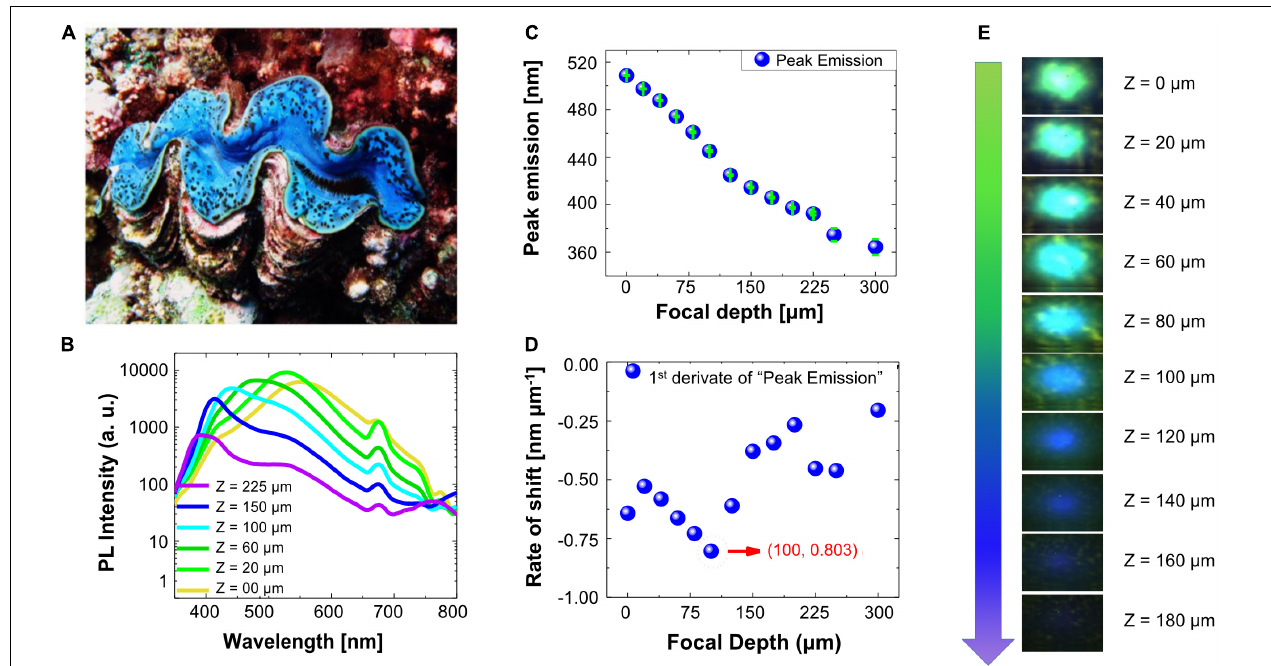
FIGURE 5 | (A) Photo of T. maxima specimen with blue mantle coloration. (B) Photoluminescence (PL) spectra of T. maxima at room temperature for different focal depths (exemplarily shown for six focal depths, ranging from mantle surface to 225 µ m within the tissue). (C) Peak emission wavelengths (nm) of T. maxima photoluminescence versus focal depth ( µ m). Green bars represent the standard error, obtained by a Gaussian fit. (D) Rate of peak shift (nm µ m - 1 ) in T. maxima photoluminescence versus focal depth ( µ m). (E) Illustration showing the color changes in PL with varying focal depth ( Z ), where Z = 0 is directly at the giant clam mantle surface and Z > 0 indicates measurements deeper inside the mantle tissue.